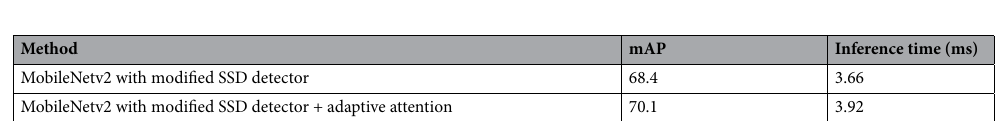
Table 4. MobileNetv2 with modified SSD detector evaluation results on the PASCAL VOC